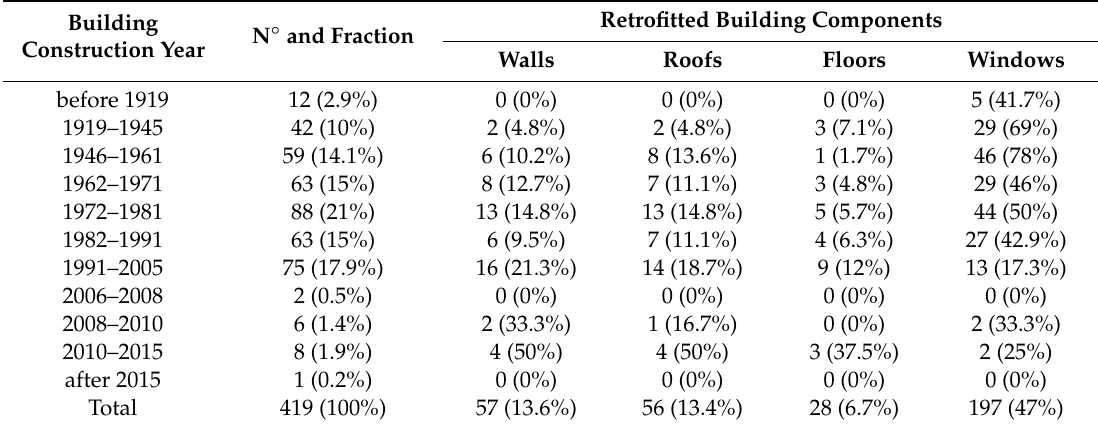
Table 2. The sample buildings subdivision by construction years and retrofitted building components.